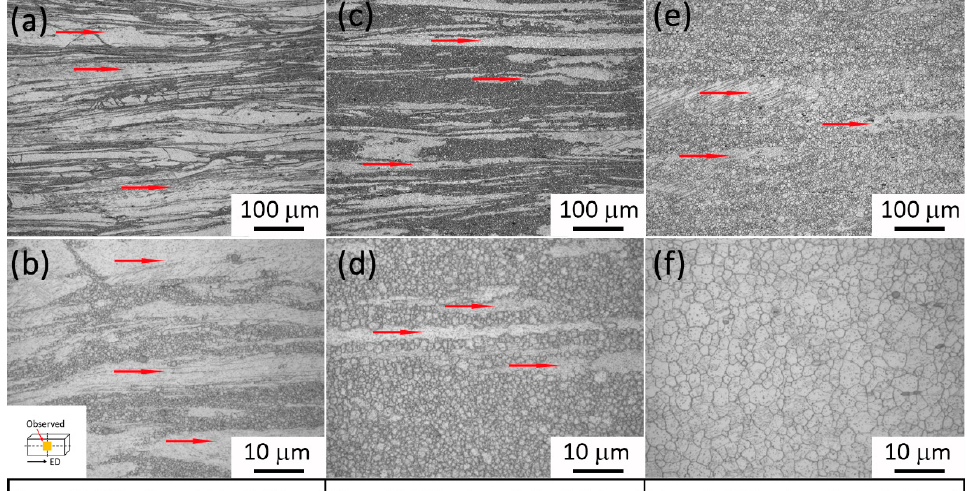
Figure 5. Optical micrographs of the as-extruded ZX10 alloy at different temperatures. ( a , b ) 300 °C, ( c , d ) 350 °C, and ( e , f ) 400 °C. The red arrows indicate large unDRXed grains.